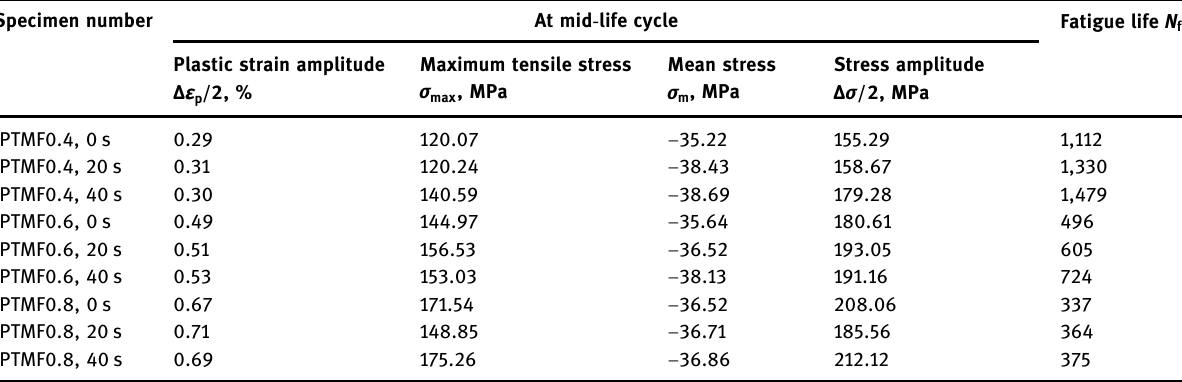
Table 3: Summary of TMF experiments results Specimen number At mid - life cycle Fatigue life N f